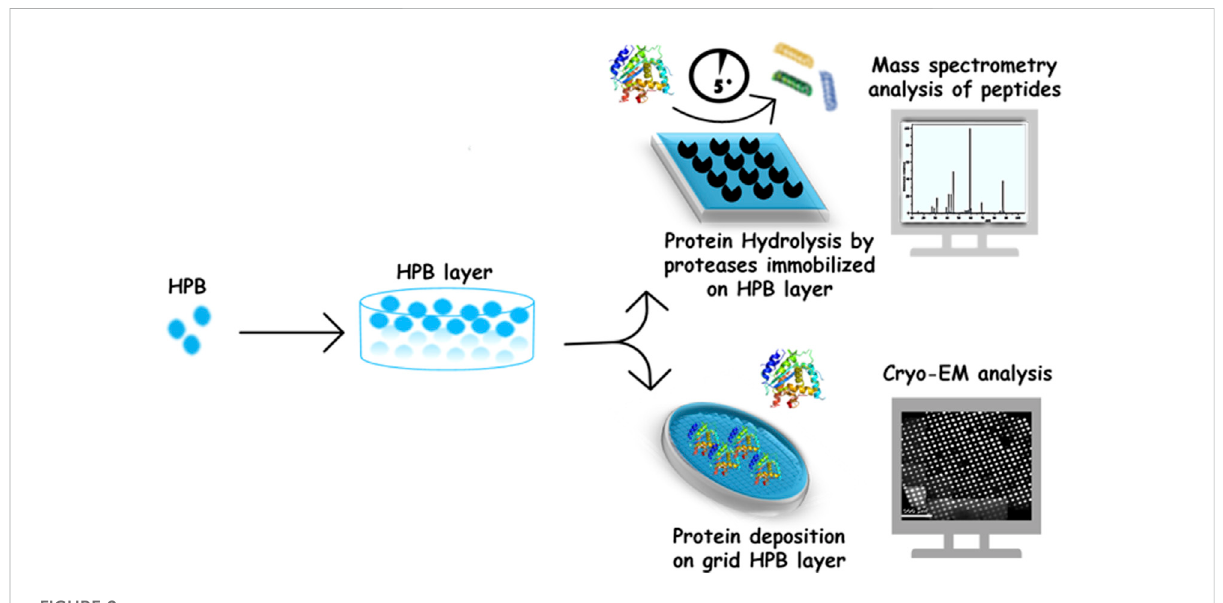
FIGURE 2 HPB layer used in protein structure analysis and proteomic